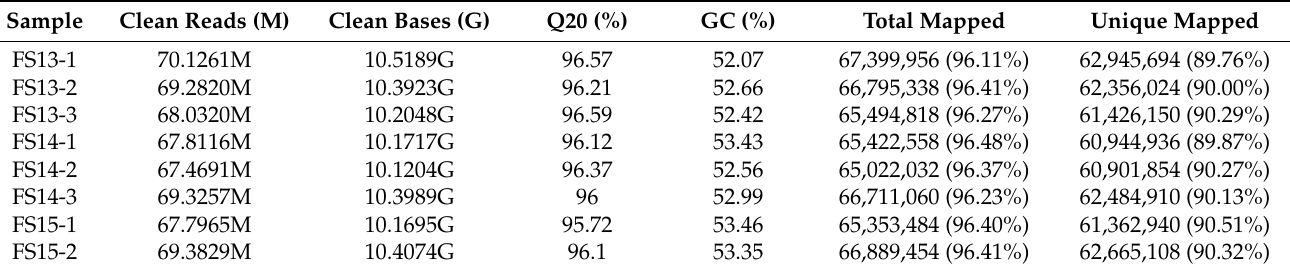
Table 1. Statistical results of RNA sequencing